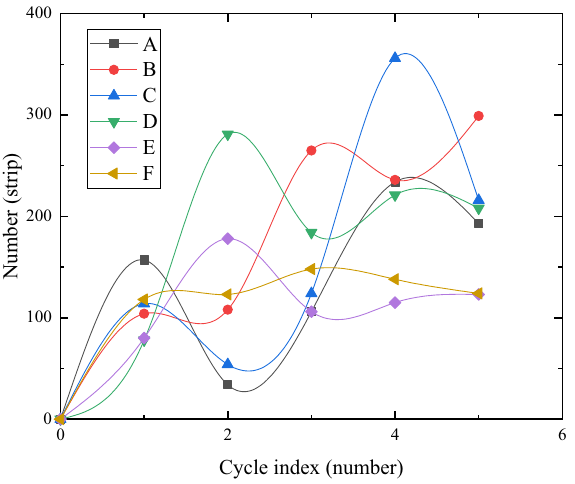
Figure 12. Development of crack number in five dry–wet cycles ( a – e ).